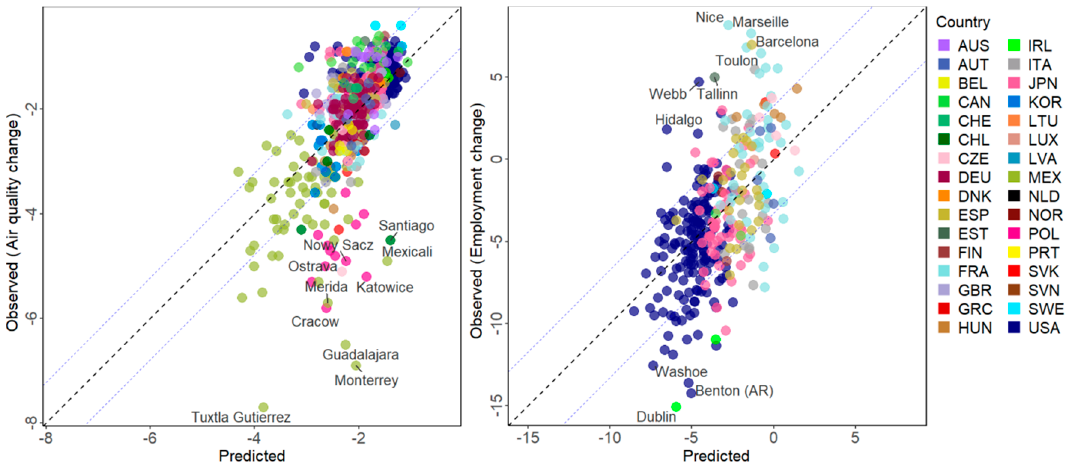
Figure 4. Observed versus predicted changes in variables according to the models. The more the FUAs, represented as points, that are closer to the 1:1 line, the better the estimation by the model. The black dashed lines show the 1:1 lines (lines of perfect fit), while the blue dashed lines show the root mean square error of the model ( ± RMSE). The labels for the ten FUAs with the highest errors are shown, to identify outliers. The units are air quality, PM2.5 in µg/m³, and employment, %.